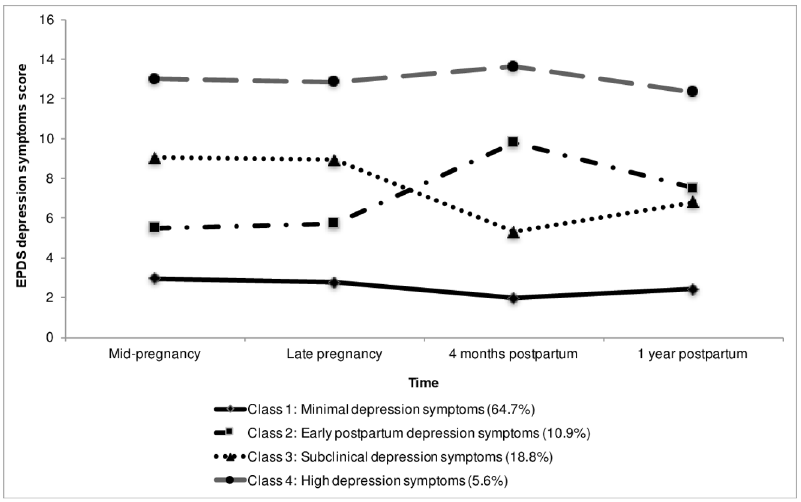
Fig 1. Estimated means of the EPDS for the four trajectories of maternal depressive symptoms from pregnancy to one year postpartum.